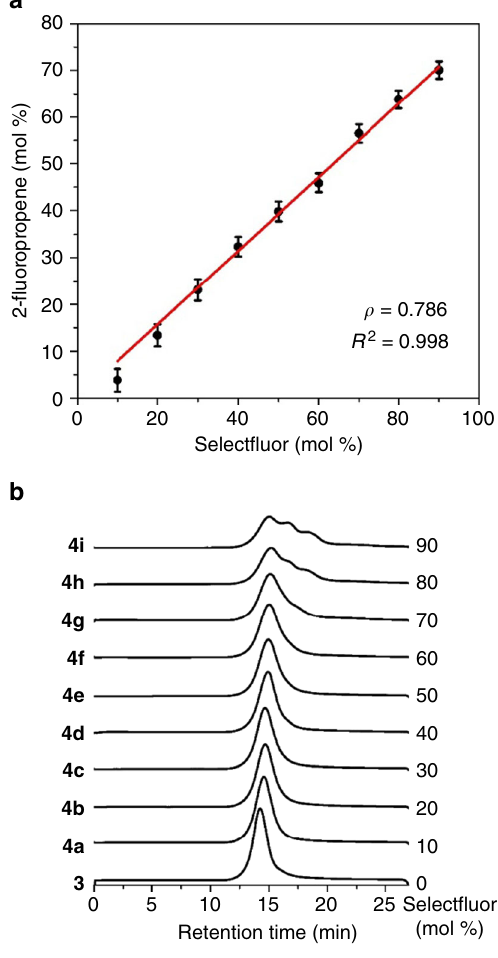
Fig. 2 Controlled decarboxylative fl uorination of PMAA 3 in